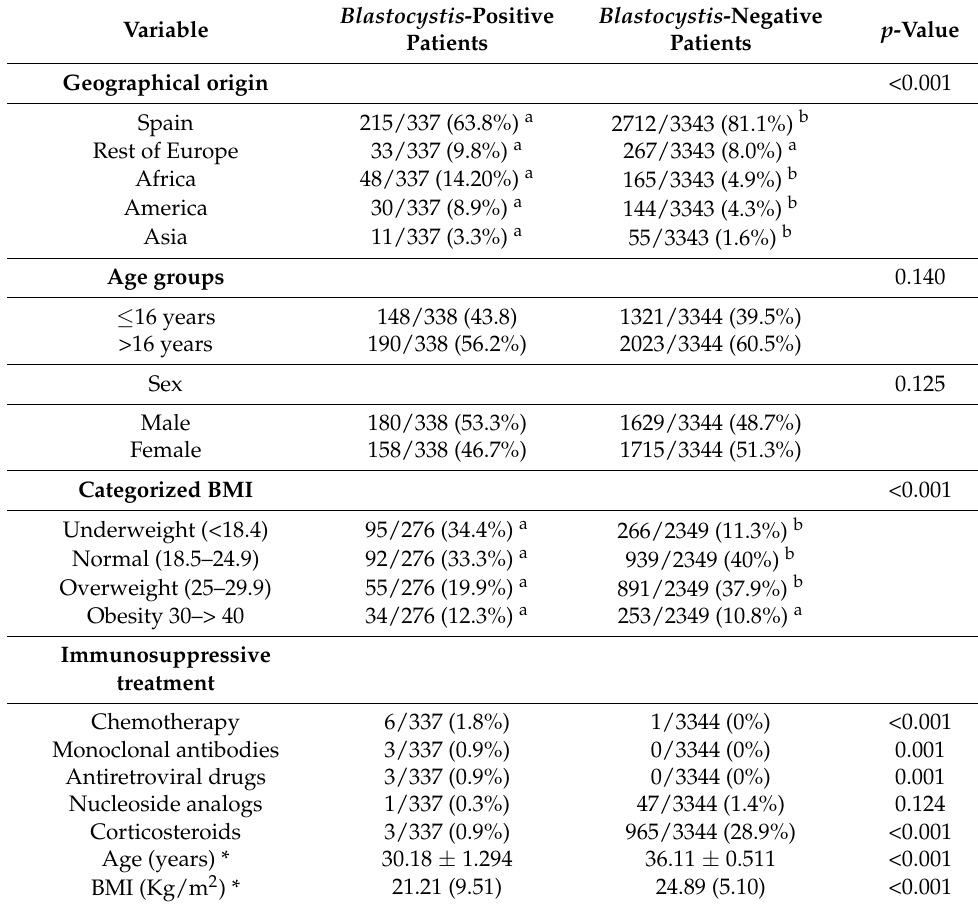
Table 1. Distribution of demographic/anthropometric parameters and immunosuppressive treatment in cases ( Blastocystis -positive patients) and in controls ( Blastocystis -negative